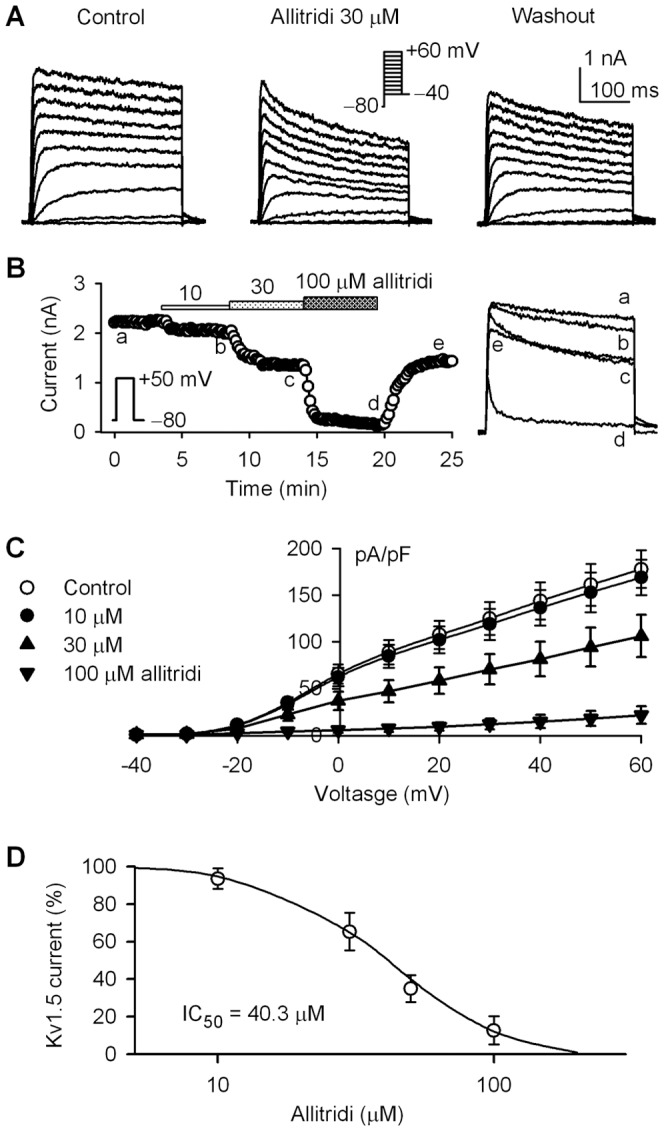
Effect of allitridi on hKv1.5 current.
A. Voltage-dependent hKv1.5 current recorded in a representative cell with the voltage protocol as shown in the inset, in the absence and presence of 30 µM allitridi. B. Time-course of hKv1.5 current recorded in a typical experiment with the voltage protocol (inset) in the absence and presence of 10, 30, and 100 µM allitridi. Original current traces at corresponding time points are shown in right side of the panel. C. Current-voltage (I-V) relationships of hKv1.5 current in the absence and presence of 10, 30 and 100 µM allitridi (n = 8, P<0.05 or P<0.01 with 30 and 100 µM allitridi vs. control at −10 to +60 mV). D. Concentration-response relationship curve of allitridi for inhibiting hKv1.5 current was fitted to a Hill equation (n = 6–8 for each concentration).